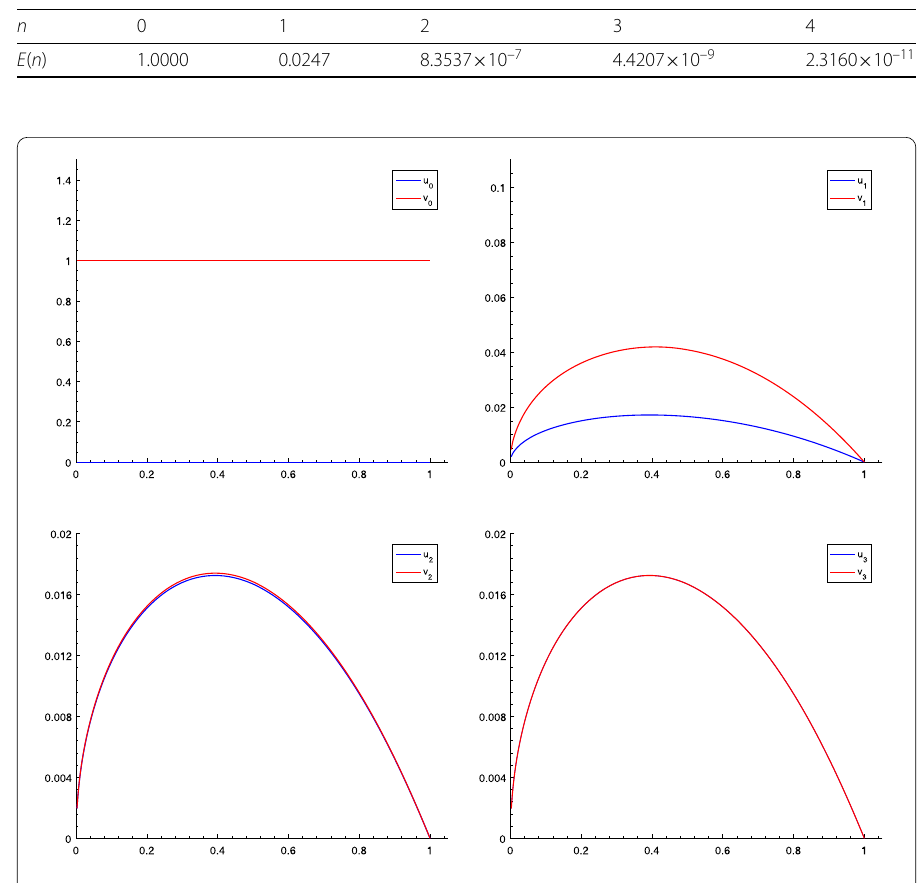
Figure 1 The graphs of u n and v n , n = 0,1,2,3, for